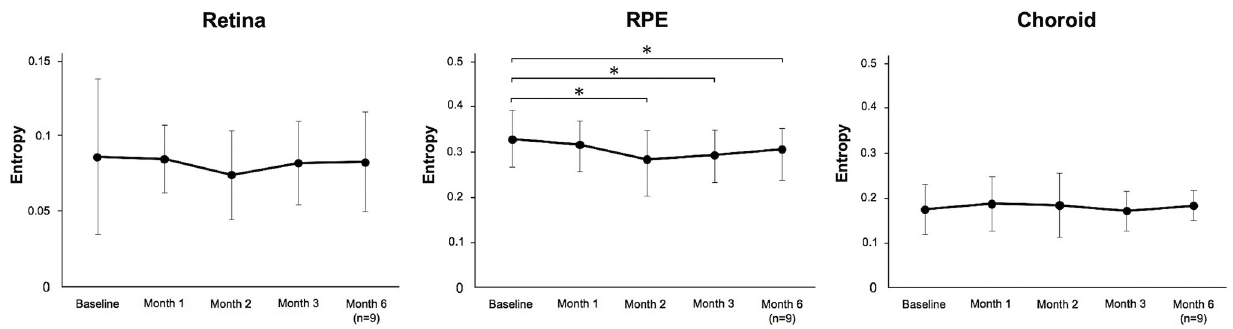
Fig 7. Changes in mean entropy values on SMPL-irradiated sectors according to ETDRS grid in each en face layer (n = 11). The mean entropy of the RPE layer tended to be lower at the 1-month timepoint (P = 0.24) and was significantly lower at the 2-month, 3-month, and 6-month timepoint after SMPL than at baseline value (P < 0.01, each). The results are the means ± standard